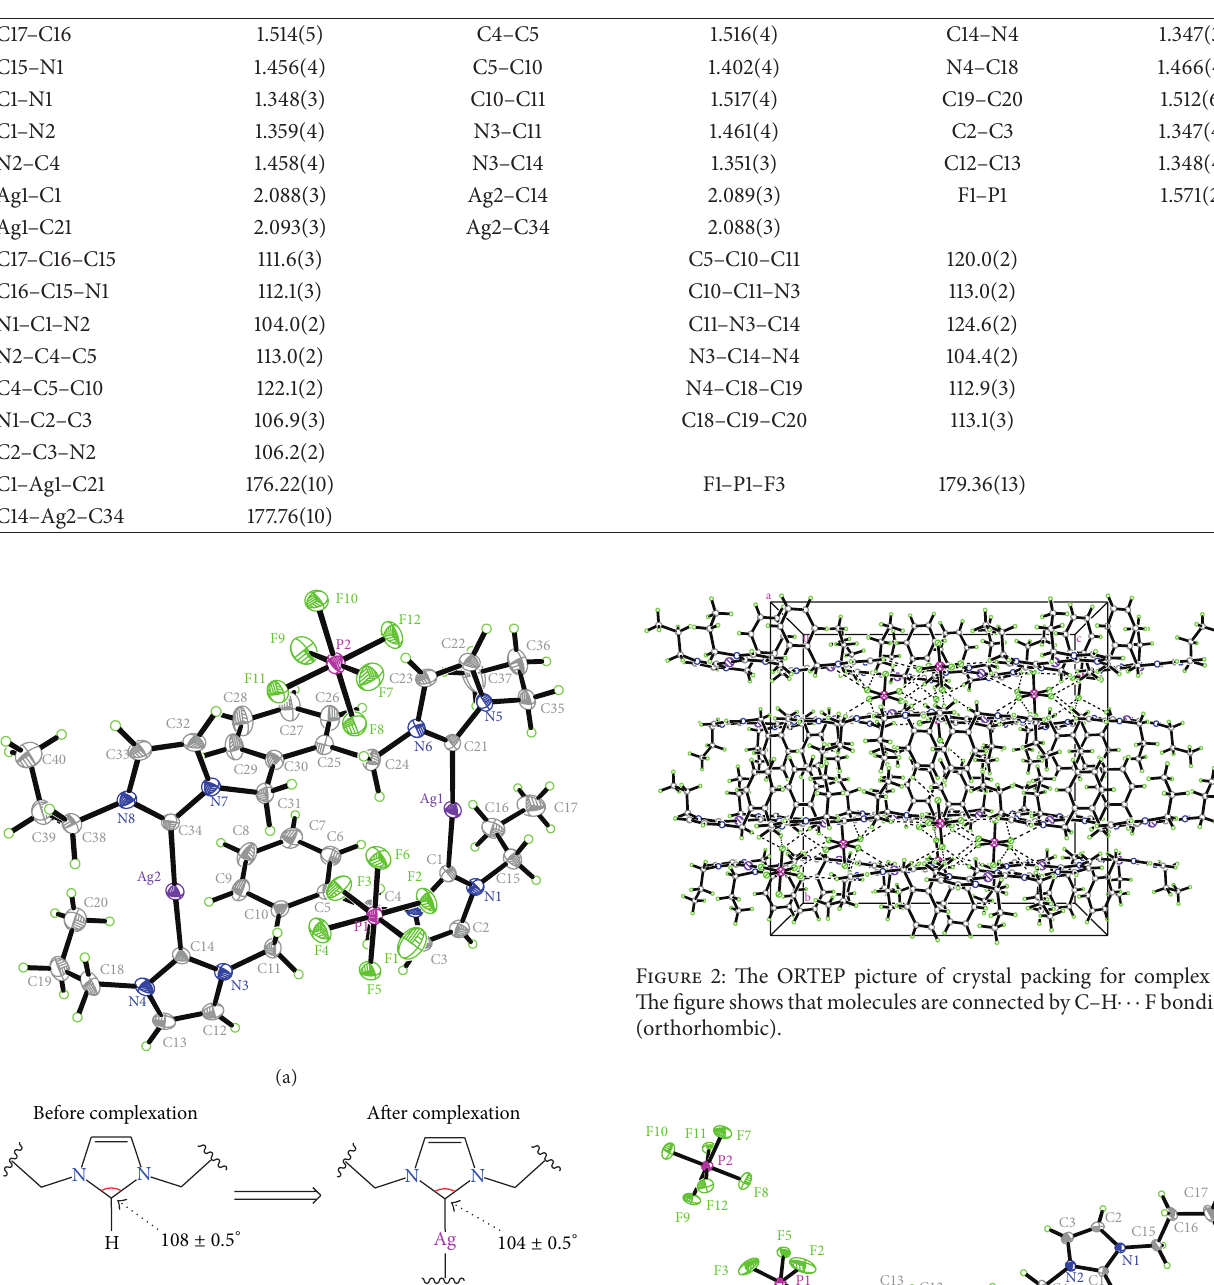
Table 2: Selected bond lengths (˚A) and angles ( ∘ ) of silver complex 6 .